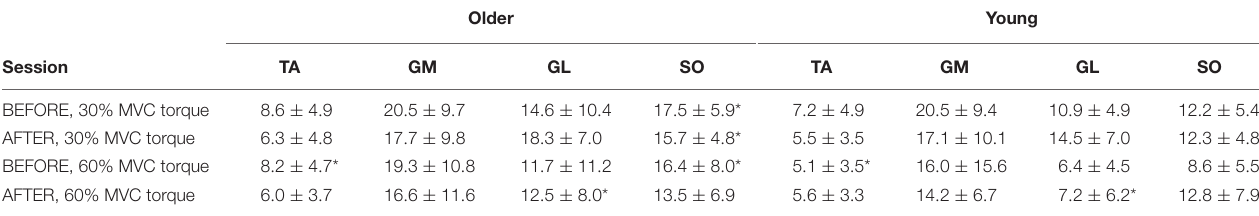
TABLE 1 | Number of motor units (Mean ± Standard Deviation) identified from different muscles in the BEFORE and AFTER sessions (PNR ≥ 28 dB). Older